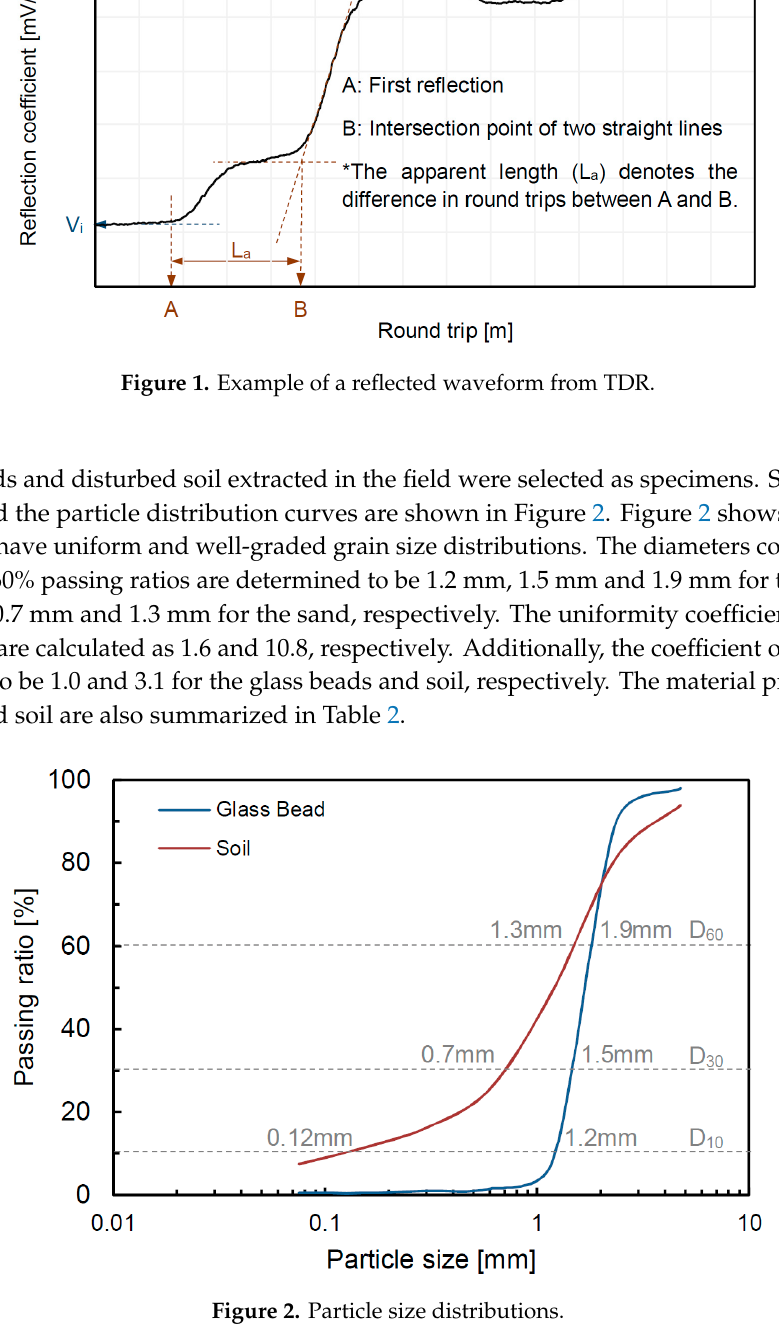
Figure 1. Example of a reflected waveform from TDR.